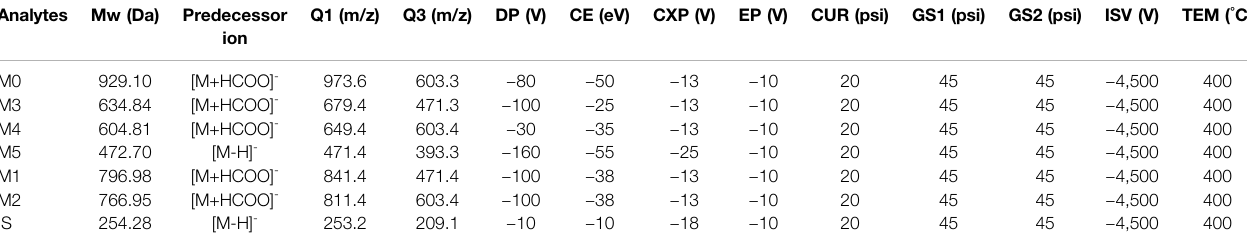
TABLE 1 | Optimized mass spectrum parameters for quanti fi cation of ASD, internal standards and metabolites (M1 – M5). Analytes Mw (Da) Predecessor ion